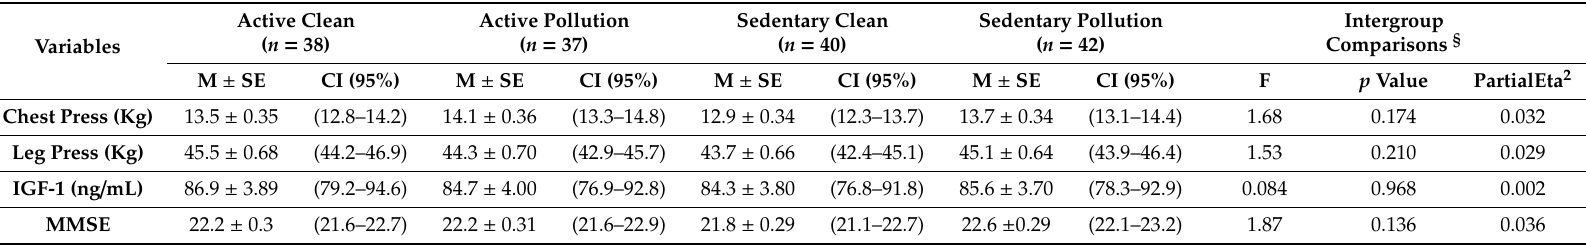
Table 3. Intergroup comparisons: PRE-test *.